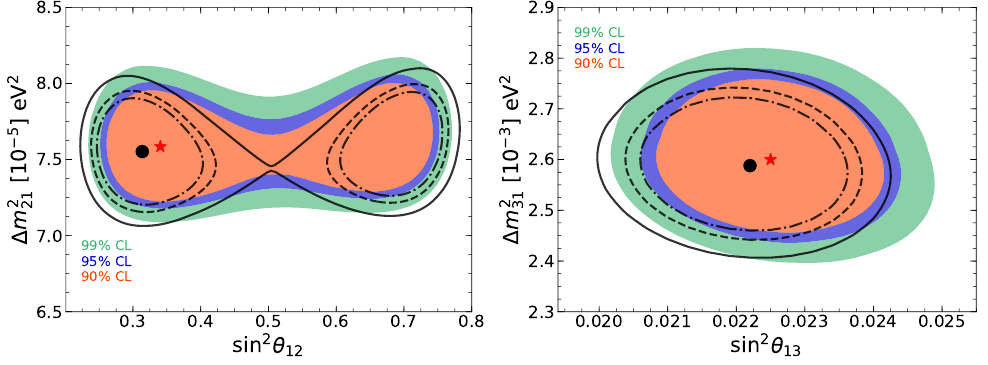
Figure 3 . 90, 95 and 99% CL (2 d.o.f.) allowed regions in the sin 2 θ 12 - ∆ m 2 ∆ m 2 (right) planes from our combined analysis of RENO + Daya Bay + KamLAND data including 31 decoherence (filled regions, red stars) and assuming a perfectly coherent source (black empty con- tours, black